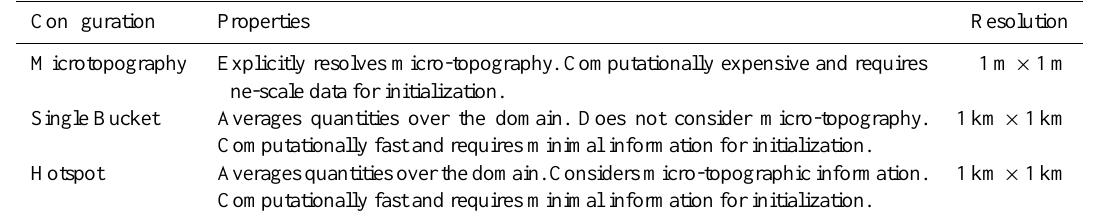
Table 1. Description of the different configurations of the Hummock–Hollow (HH) model used in the present paper. Configuration Properties Resolution Microtopography Explicitly resolves micro-topography. Computationally expensive and requires fine-scale data for initialization. Single Bucket Averages quantities over the domain. Does not consider micro-topography. Computationally fast and requires minimal information for initialization. Hotspot Averages quantities over the domain. Considers micro-topographic information. Computationally fast and requires minimal information for